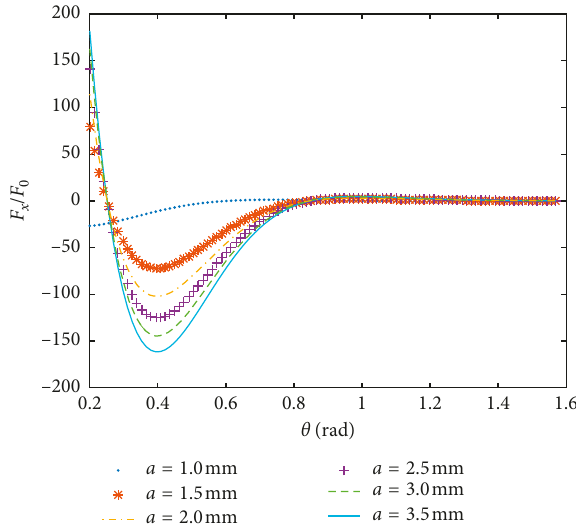
Figure 11: Relationship between image force F different values of the crack length a .